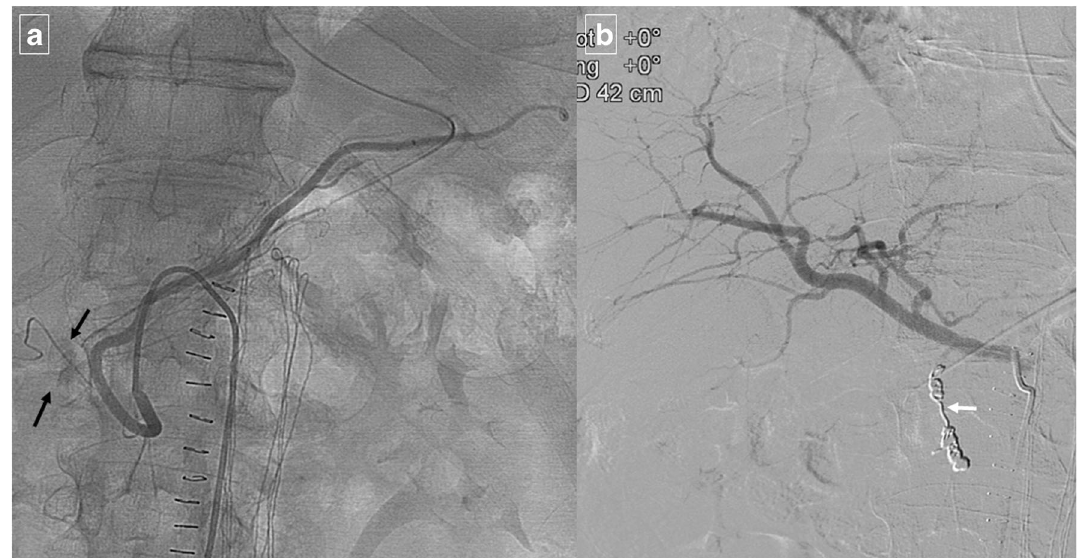
Fig. 12 A 63-year-old male smoker with upper digestive bleeding. Initial upper endoscopy showed a large bleeding ulcer on the anterior surface of the duodenal bulb; sclerosing therapy with adrenaline and aethoxysklerol® was unsuccessful. a Arteriogram shows contrast